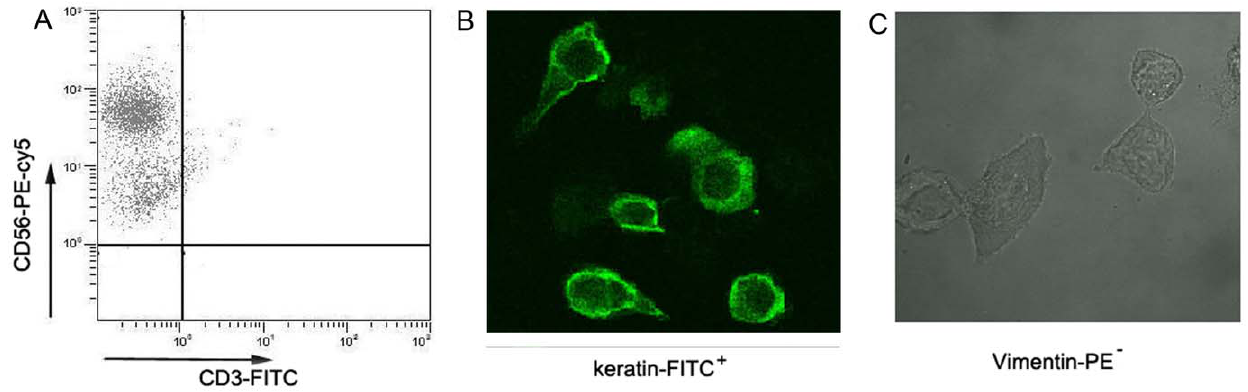
Figure 1. dNK cells and EVT cells identification. Phenotypic analysis of isolated CD3 2 CD56 + human dNK cells and human extravillous trophoblast cells using flow cytometry and immunohistochemistry. (A) dNK cells were isolated from fresh human deciduas tissues and were stained using anti-CD3-FITC antibody and anti-CD56-PE-cy5 antibodies, and then analyzed by flow cytometry. The CD3 2 CD56 + dNK cells were about 98% pure. Human extravillous trophoblast cells were isolated from fresh villi tissues and were stained with anti-keratin-FITC antibody and anti-vimentin-PE antibody and then detected by immunohistochemistry. (B) Trophoblast cells stained for keratin. (C) Unstained trophoblasts.